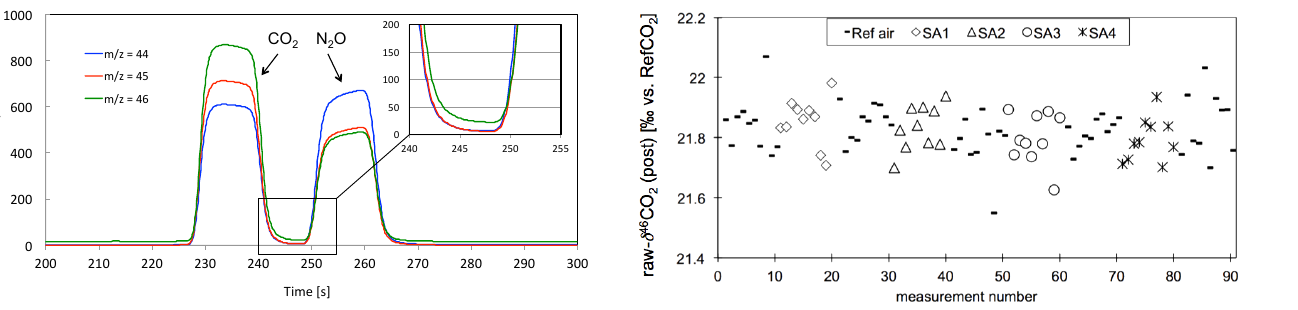
Figure 5. Full and highly efficient oxygen equilibration reaction in the CeO 2 oven represented by isotopically exchanged CO 2 of four diverse atmospheric air samples (SA1 – rhombs, SA2 – triangles, SA3 – circles and SA4 – stars) measured against the reference air (stripes). The initial differences in δ 18 O between the reference air and the air samples were up to 12‰ (relative to RefCO 2